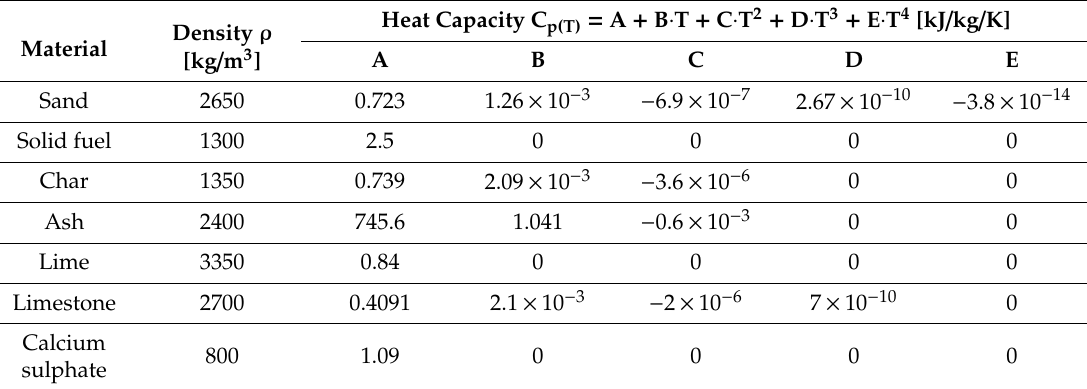
Table 7. Density and heat capacity of solid particles in the riser.